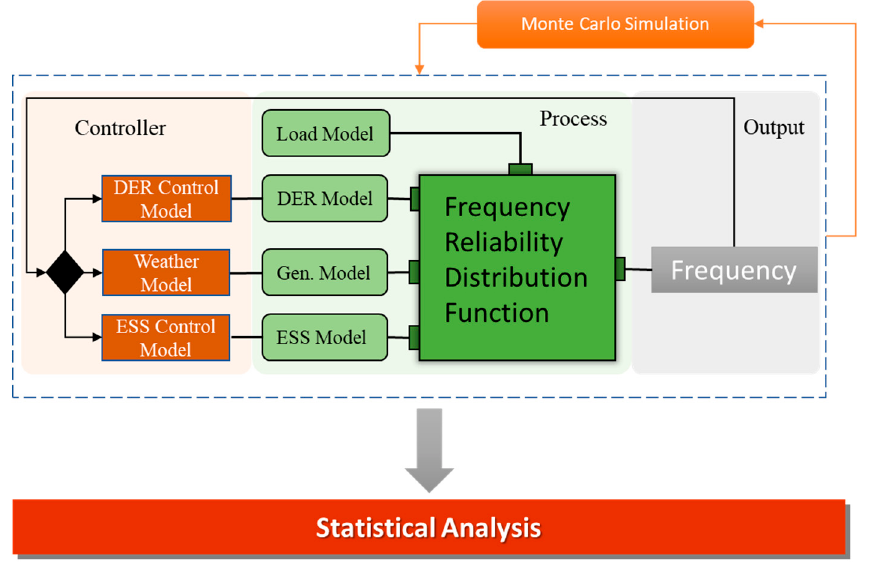
Figure 1. System framework.